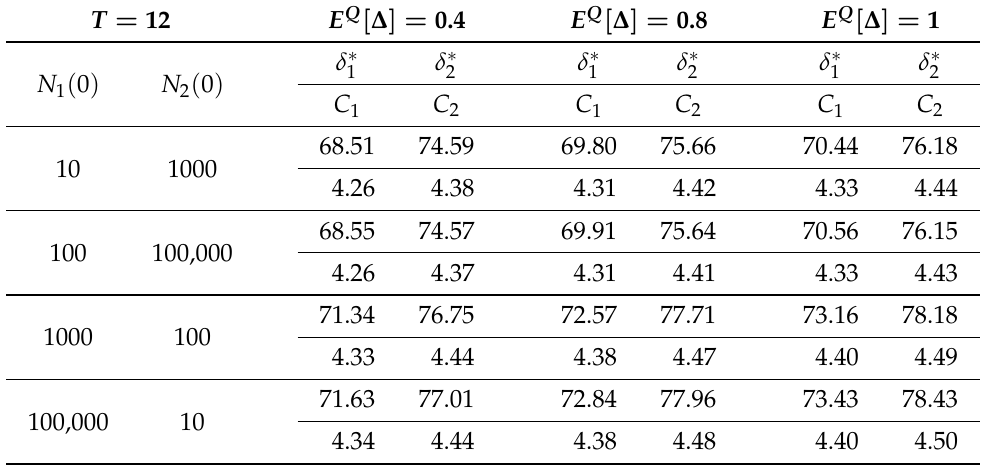
Table 3. Fair participation rates and certainty equivalent returns for Case 1 with T = 12, different portfolio sizes with N 1 ( 0 ) (cid:54) = N 2 ( 0 ) and different values of E Q [ ∆ ] . All results are in percentage. T = 12 E Q [ ∆ ] =